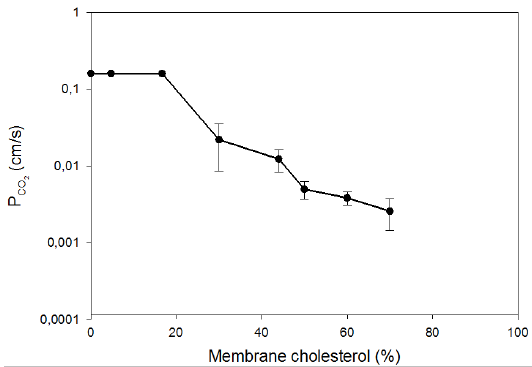
Figure 2 . CO 2 permeability (P CO2 ) of phospholipid vesicles with variable concentration of cholesterol as a function of cholesterol content in mol % cholesterol per mol total membrane lipids. P CO2 determination by the mass spectrometric 18 O exchange method. From: Itel et al. [3].